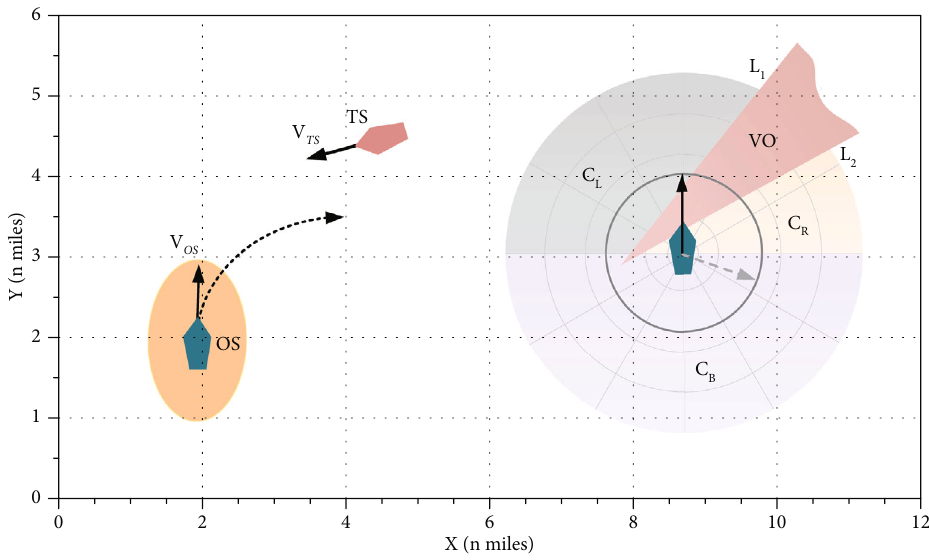
Figure 11: The diagram of collision avoiding in crossing